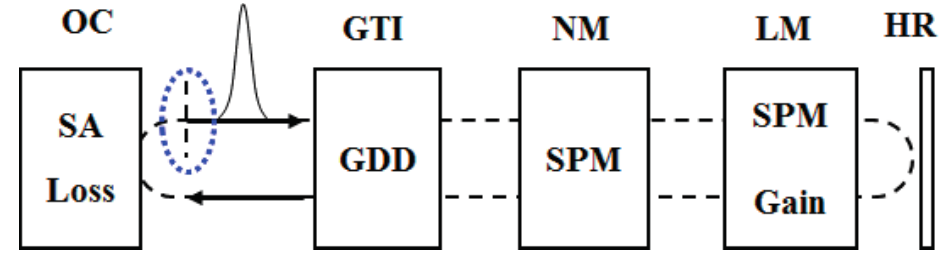
Figure 2. Block model for the mode-locked laser with a highly nonlinear intra-cavity